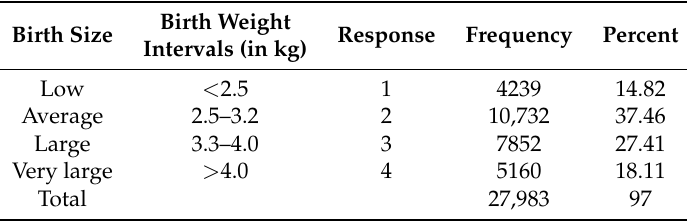
Table 1. Frequency distribution of child birth weights by size category in the 2008 Nigeria Demographic and Health Survey